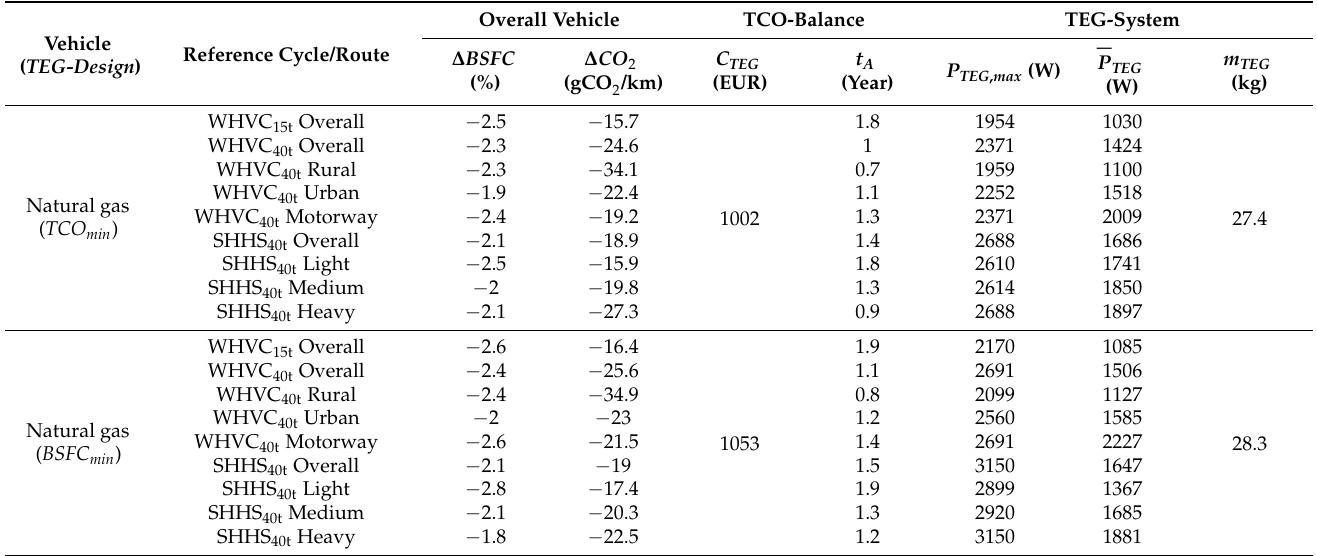
Table 5. Overview of the results achieved by using TEG in HDV ( ϑ amb = 20 ◦ C) with the objectives TCO min and BSFC min (integration: after ATS and low-temperature coolant circuit).